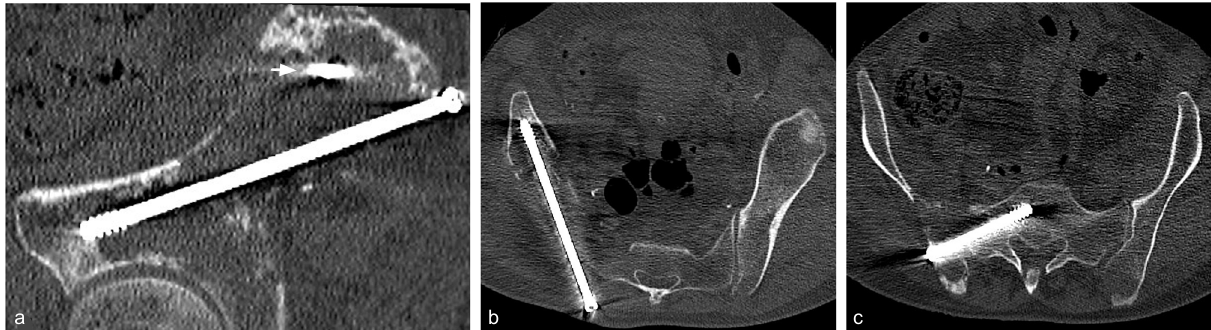
Figure 2. (a) Oblique sagittal reformatted view of the pelvis CT scan (bone window, slice thickness 1 mm) acquired after osteosynthesis ( fi rst step of the procedure). The fi rst screw was placed into the iliac bone from the posterior iliac crest to the anterior inferior iliac spine along the arcuate line. The cross section of the proximal part of the second screw inserted into the sacroiliac joint is visible (small arrow). (b) Oblique axial reformatted view of the pelvis CT scan after iliac screw fi xation. (c) Oblique axial reformatted view of the pelvis CT scan after sacral screw fi xation. This second screw was inserted into the sacroiliac joint to the sacral wing.